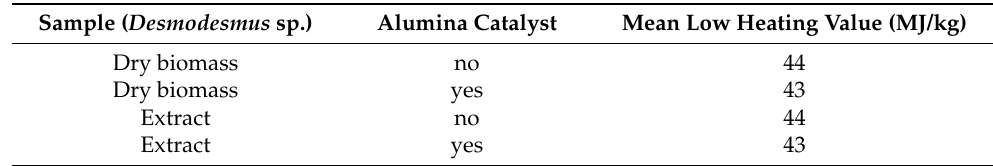
Table 4. Estimated low heating values (MJ/kg) of the C5–C12 fraction after pyrolysis at 600 ◦ C of Desmodesmus sp. microalgae and of its n-hexane extract, in presence or absence of alumina catalyst. Sample ( Desmodesmus sp.) Alumina Catalyst